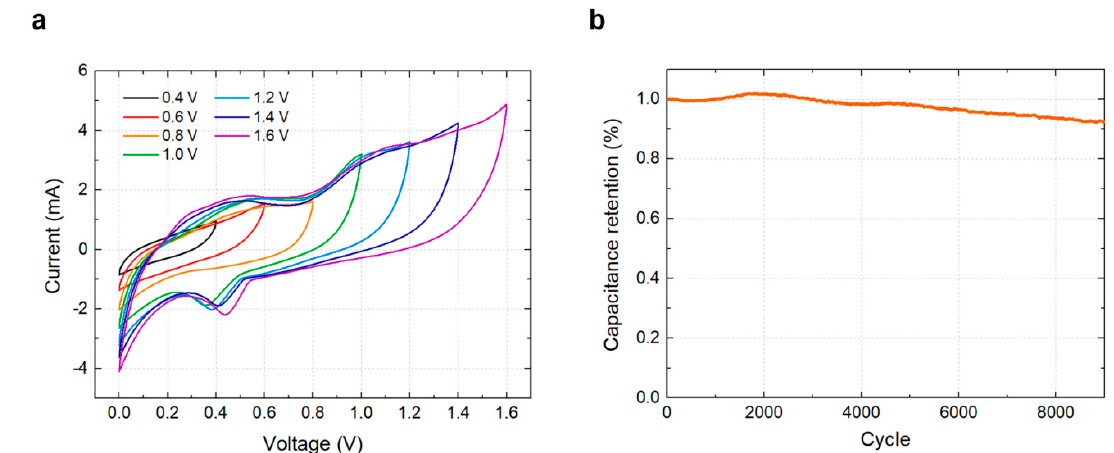
Figure 4. Voltage dependence and cyclic durability of the printed supercapacitor with PVDF-LiClO 4 GPE. ( a ) Cyclic voltammetry results at various voltage scanning ranges. ( b ) Cyclic endurance test result with 9000 charge/discharge cycles.